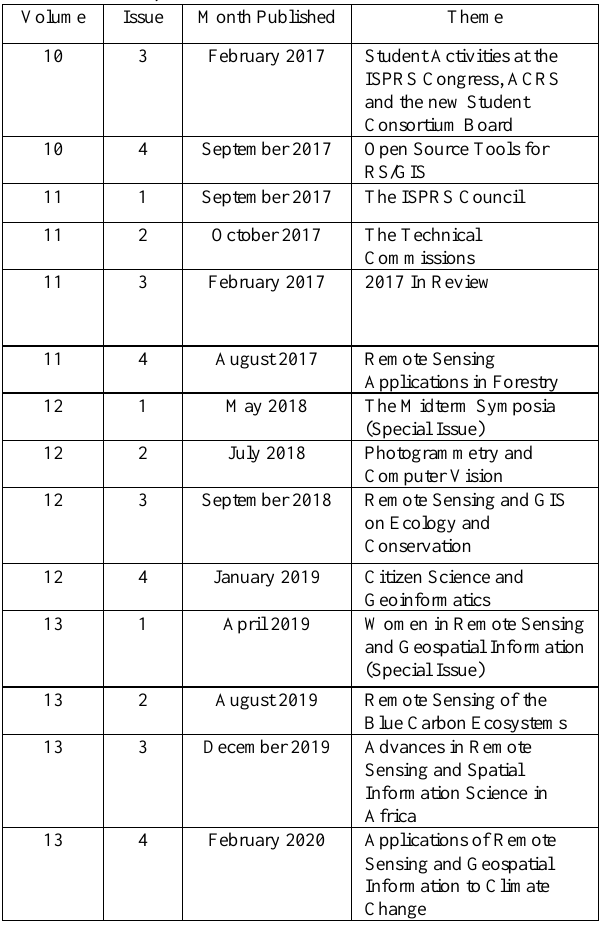
Table 2. The issues and themes of the ISPRS SC Newsletter published since the beginning of the term until the end of the year 2019. (Copies are available online: sc.isprs.org/sc-